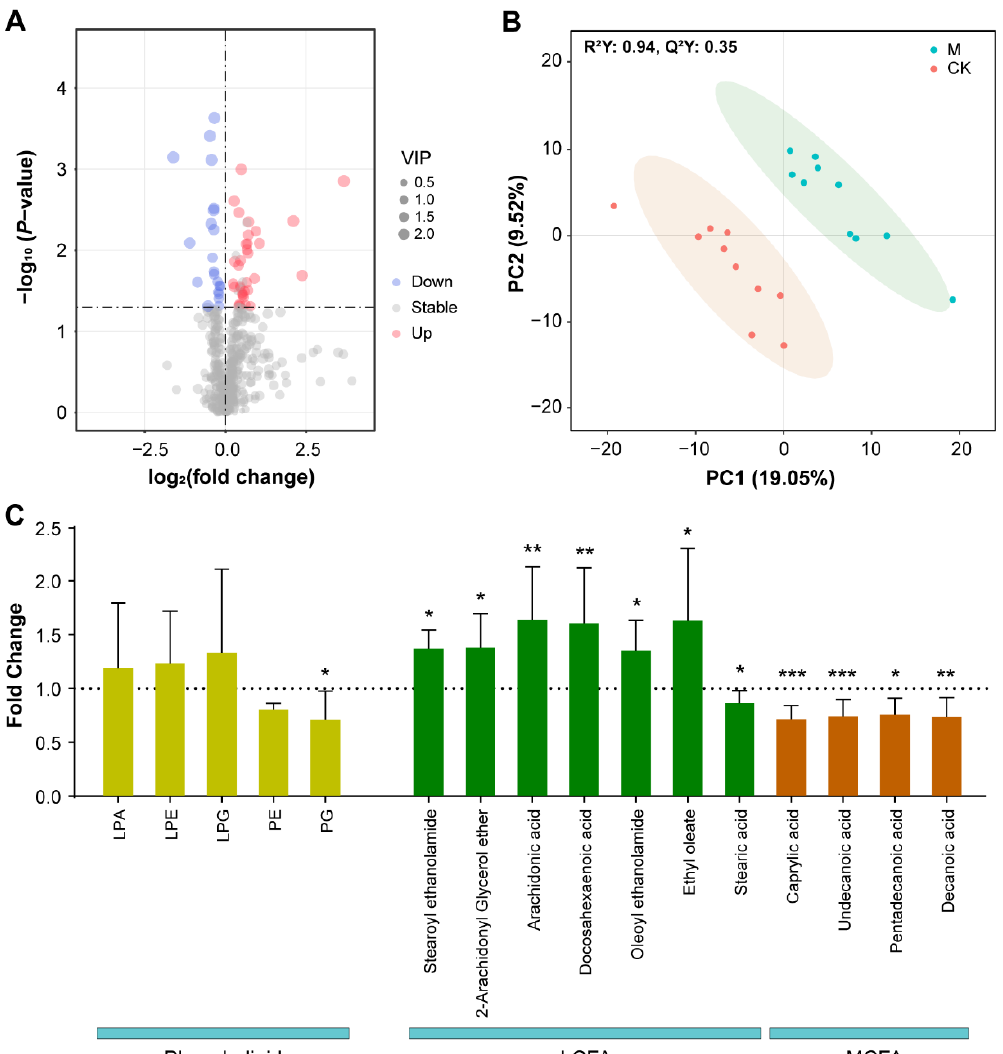
Figure 3. Metabolomic analysis of 250 mT SMF effects on E. coli metabolites. ( A ) Volcano map of the identified metabolites. Upregulated and downregulated metabolites with significant difference between SMF-treated and -untreated groups are shown as red and blue dots. Metabolites with no significant change are shown as gray dots. The size of dot represents the variable importance in projection (VIP). ( B ) PLS-DA score plots of the samples using metabolome data from ten independent biological replicates. ( C ) Effect of SMF on contents of phospholipids, LCFA and MCFA. Data shown as mean ± SD. Ten independent biological repeats were analyzed. Statistical analysis was performed by t -test. * p < 0.05, ** p < 0.01, *** p <